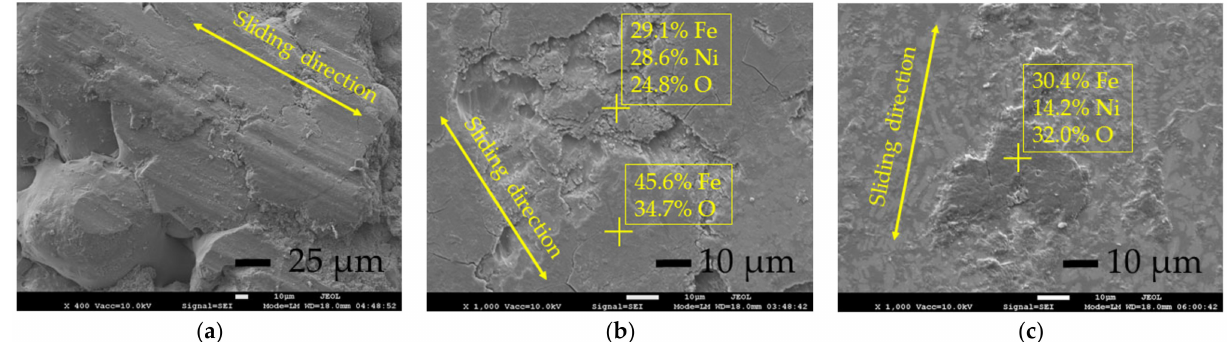
Figure 14. SEM images of wear tracks after two body dry sliding test of as-sprayed ( a ), sprayed and remelted in furnace ( b ) and laser processed ( c ) coatings: the concentrations of elements in marked points are given in wt.% (by